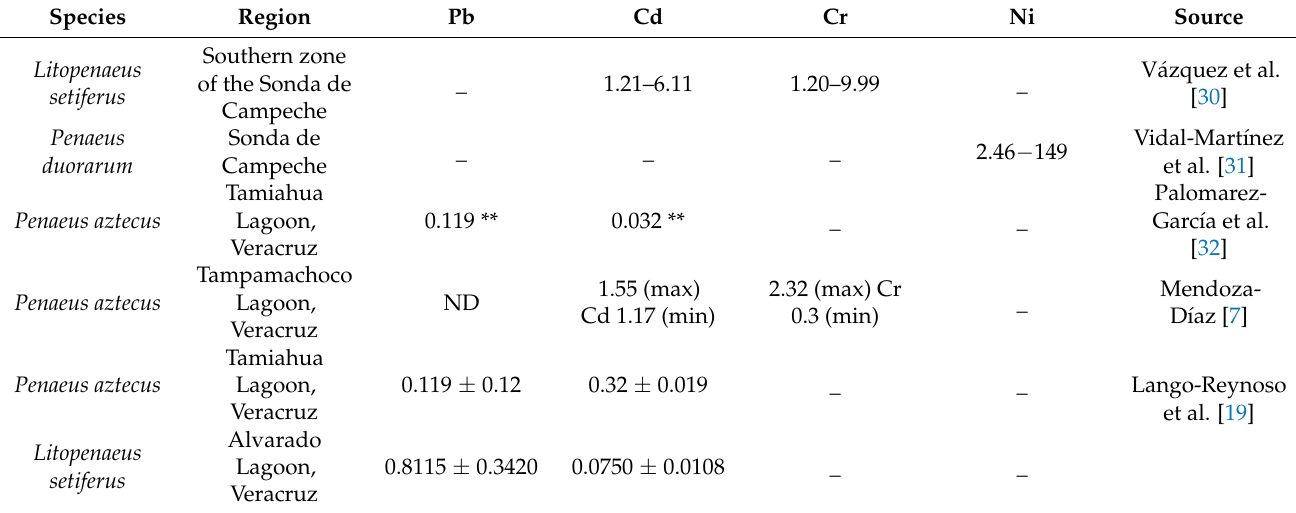
Table 1. Concentration of toxic metals ( µ g g − 1 ) in penaeid shrimp species from the Gulf of Mex- ico